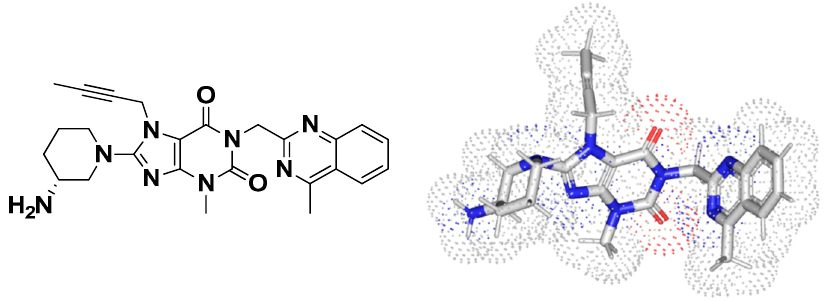
Figure 8. Two- and 3D-dimensional structural representation of linagliptin (LIN).